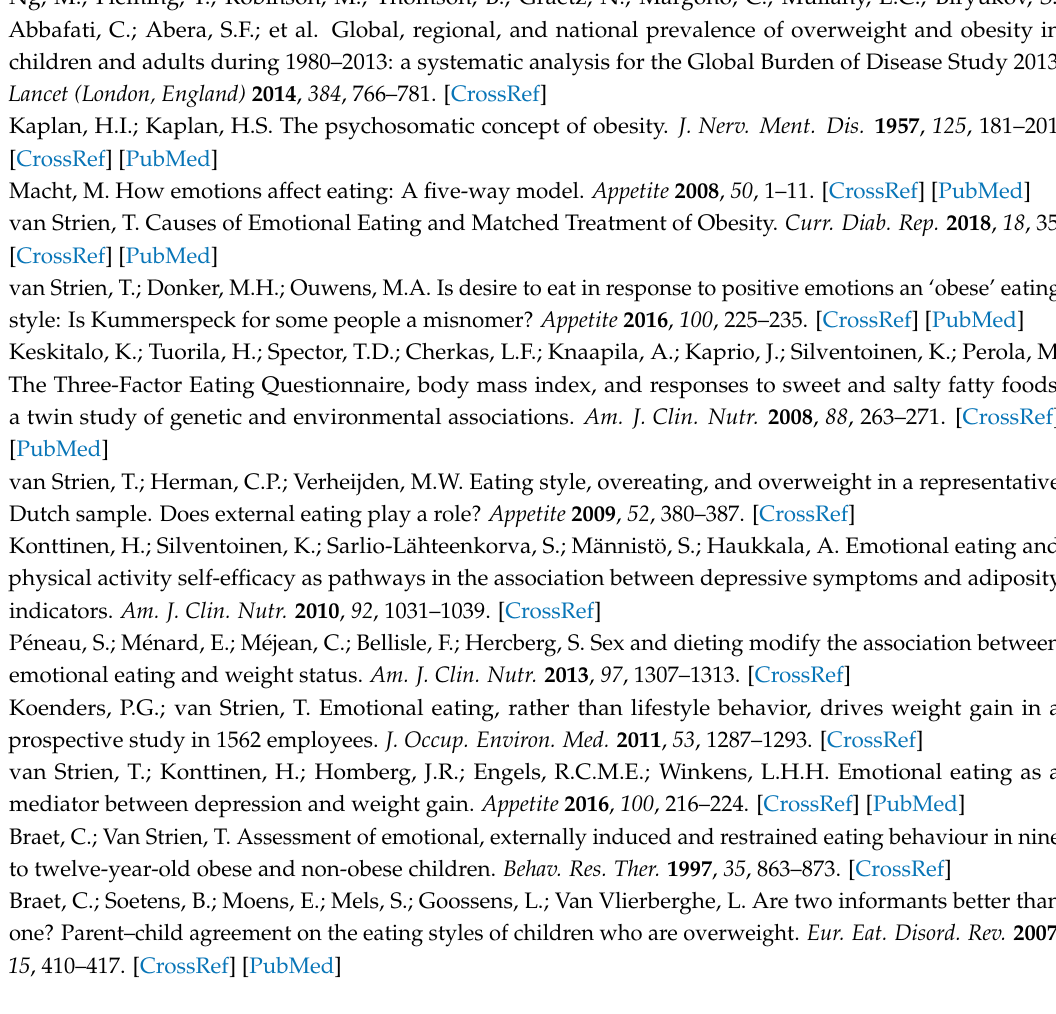
Figure S1: Item level frequencies of the original Emotion-Induced Eating